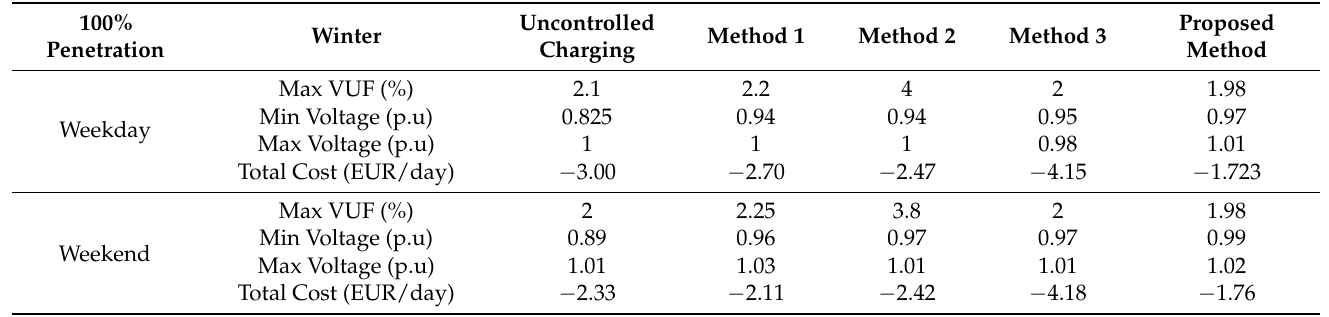
Figure 21. Total cost and SOC. ( a ) Charging cost in different electric load profiles (weekend). ( b ) Average SOC in different electric load profiles (weekend). Table 6. Comparison of result of the case study under different load